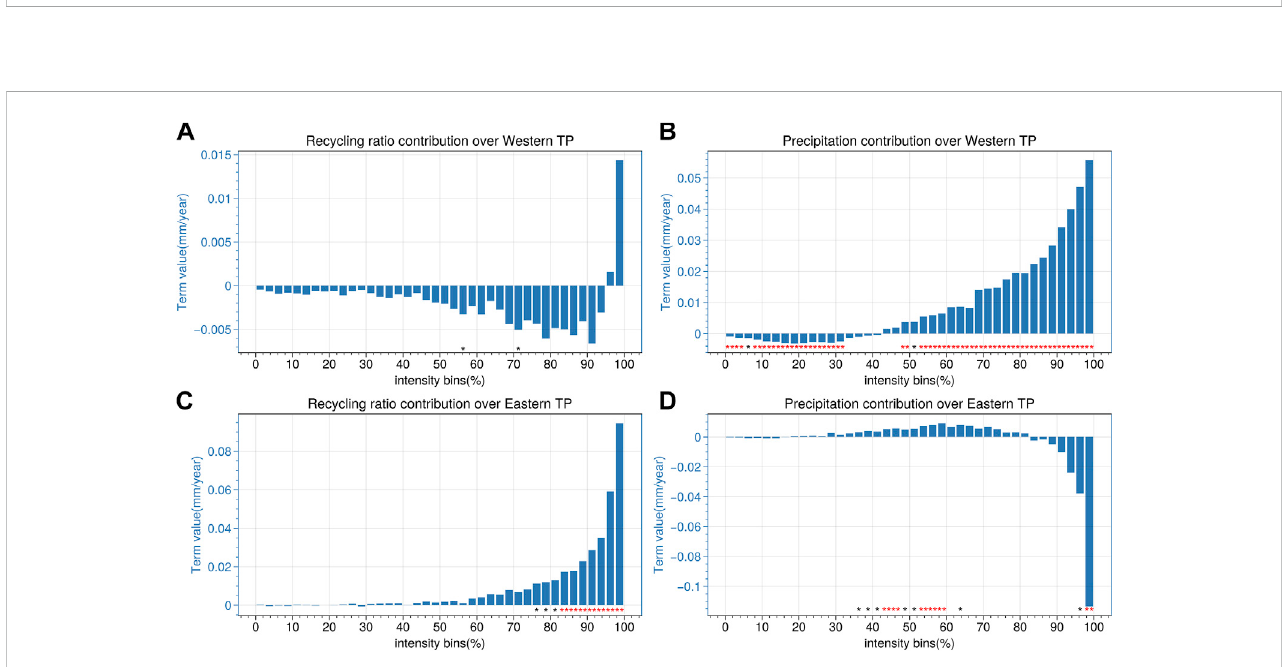
FIGURE 7 Decomposition of internal precipitation trends to the PRR and precipitation over the western TP and eastern TP. Linear trends of internal precipitation associated with PRR (A,C) and precipitation (B,D) over the western TP (A,B) and eastern TP (C,D) . The red stars and black stars indicate statistical signi fi cance exceeding 95% and 90%,